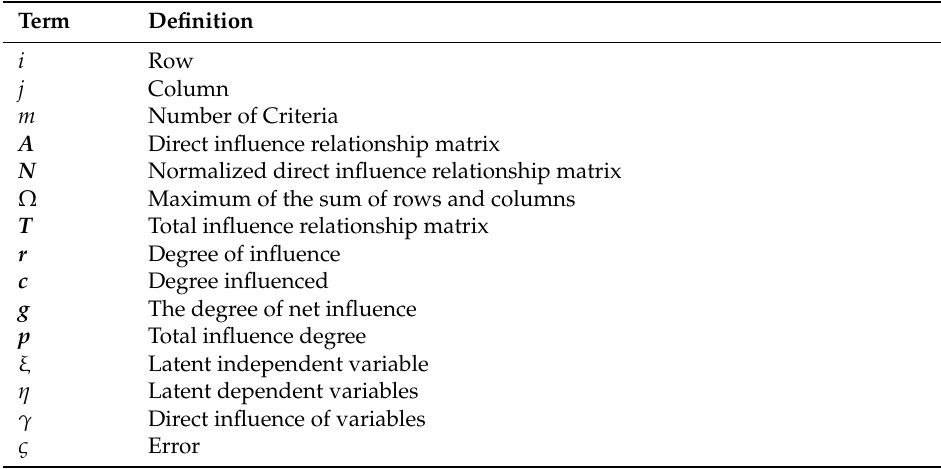
Table A1. List of symbols.